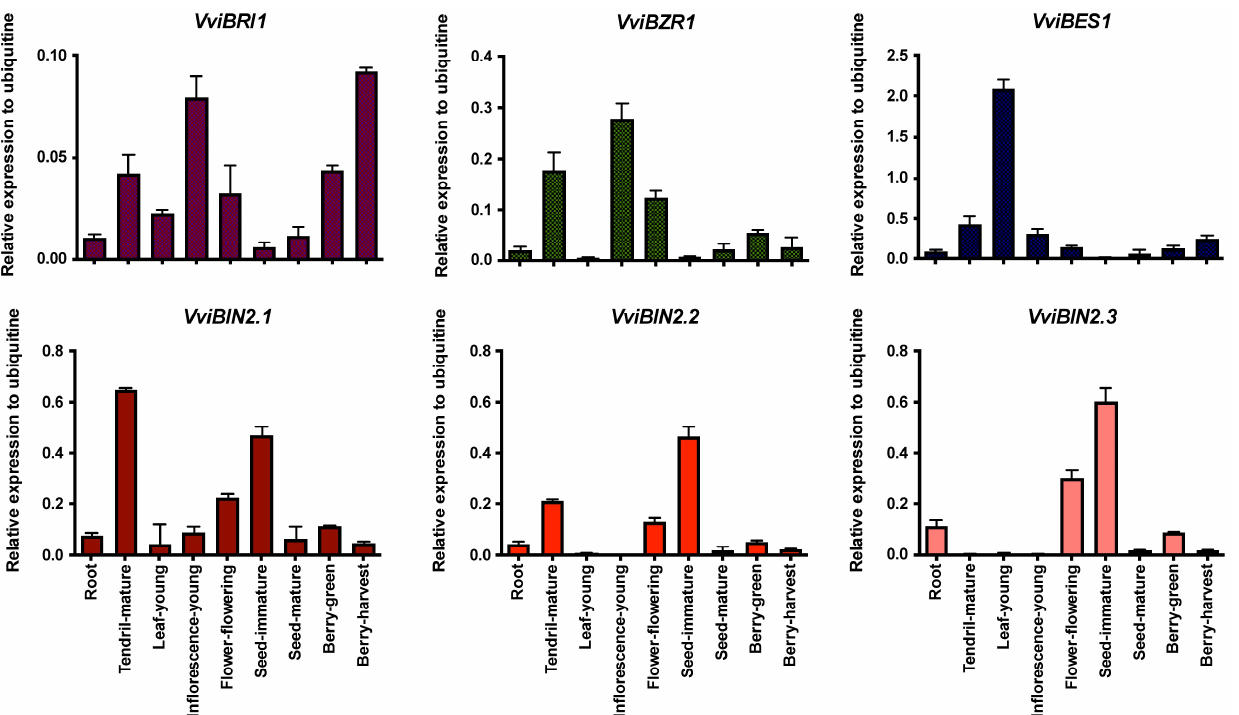
Figure 4. Expression levels of genes involved in brassinosteroid perception and signaling in cv. Cabernet sauvignon grapevines. Expression data was normalized against the reference gene, VviUBI . Bars are the mean ± standard deviation of three biological and three technical replicates. Each biological replicate corresponds to a pool of tissue collected from five different